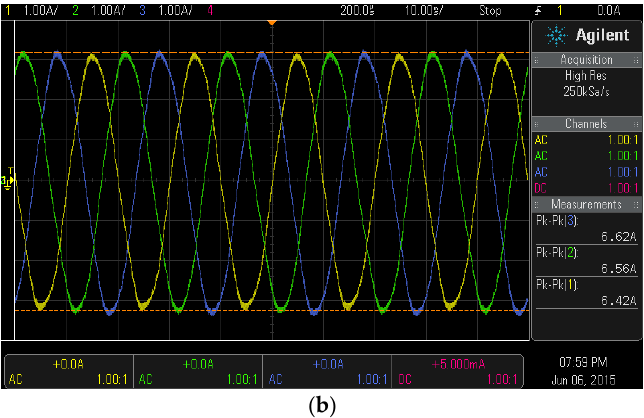
Figure 14. Output current waveforms ( i.e. , I a , I b , and I c ) of the three-phase inverter with R load for ( a ) simulation and ( b ) experimental.